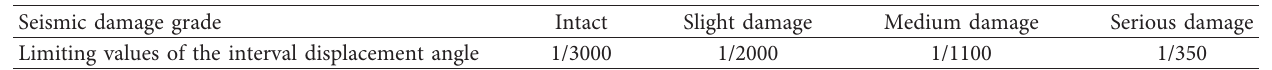
Figure 10: Cloud diagram of wall peak displacement under Loma Prieta earthquake with 7-degree fortification intensity. (a) X -direction. (b) Y -direction. Table 4: Limiting values of interval displacement angle of masonry